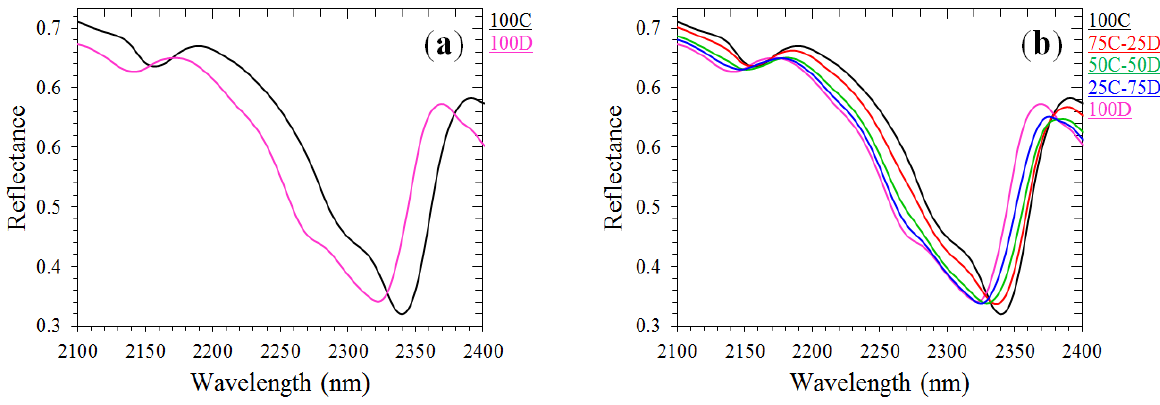
Figure 5. Laboratory spectral endmembers of ( a ) pure and ( b ) mixed calcite and dolomite synthetic samples (C = calcite and D = dolomite, prefix numbers showing the mineral contents in percent) (Modified after Zaini et al.